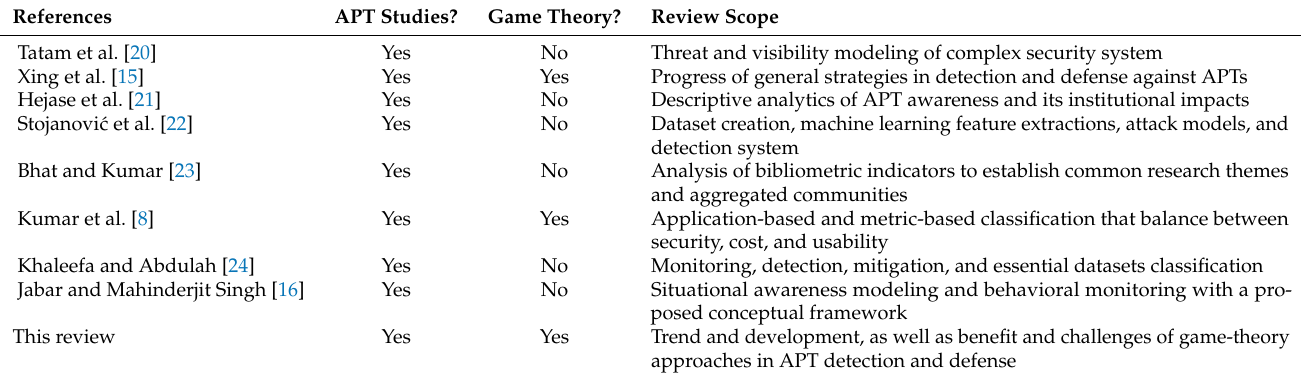
Table 1. Summary of the differences between the current review and previous review